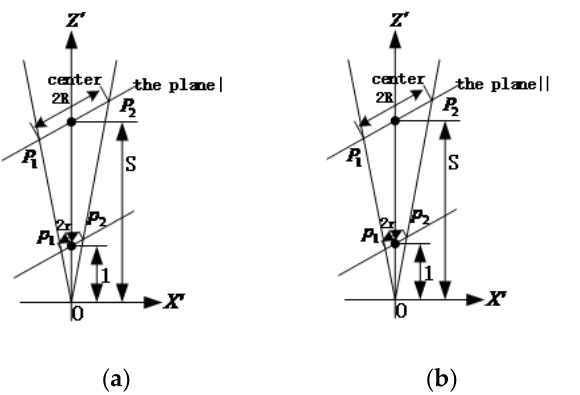
Figure 2. Cross-section plane and cone intersect in a circle with radius R. ( a ) Cross-section plane I; ( b ) Cross-section plane II.